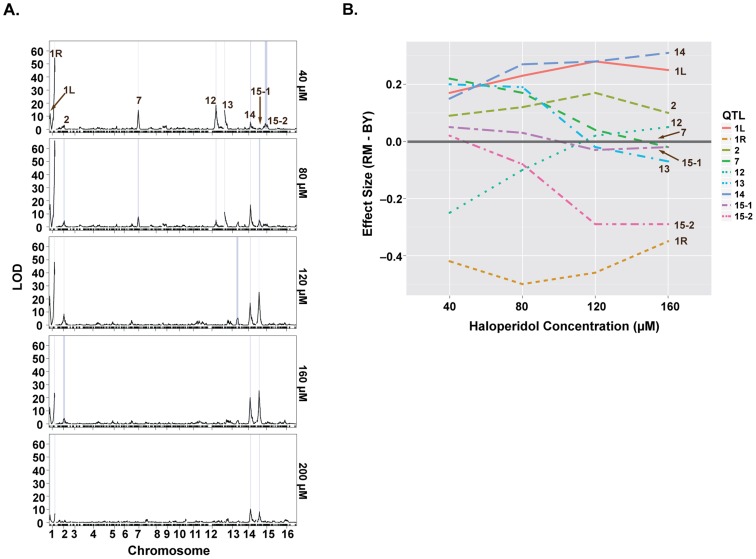
Loci underlying haloperidol resistance have dose-dependent effects.(A) LOD profiles for growth in the presence of increasing doses of haloperidol. Significant loci are shown through their 1.5-LOD drop confidence intervals (blue rectangles). (B) Effect sizes of QTL underlying haloperidol resistance as a function of dose. Effect sizes were calculated via regressing segregant phenotype on genotype (1 versus -1) at a specified locus. Positive values represent better growth in the presence of the BY allele.